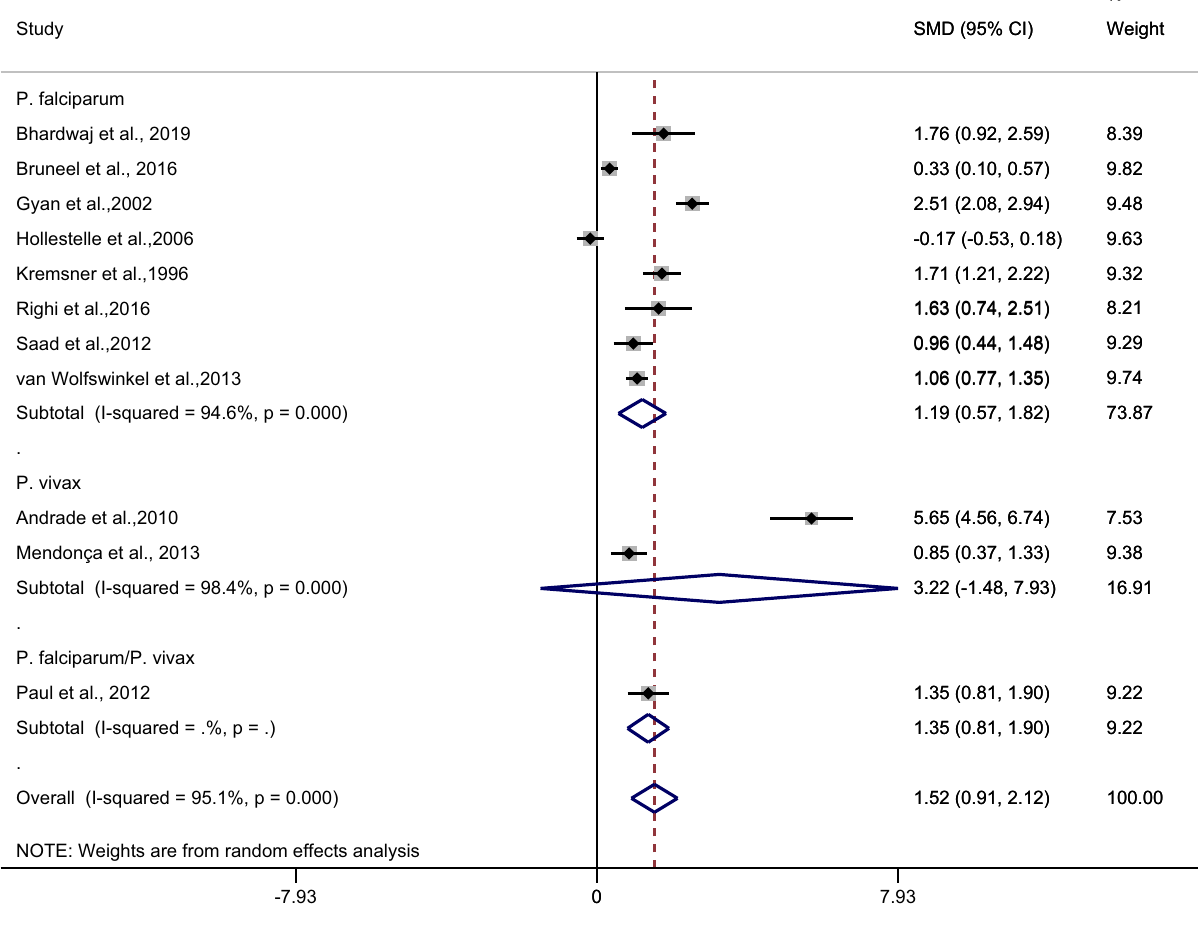
Figure 4. Forest plot demonstrates the difference in the mean CRP level between patients with severe and uncomplicated malaria by types of infections. SMD, standard mean difference; CI, confidence